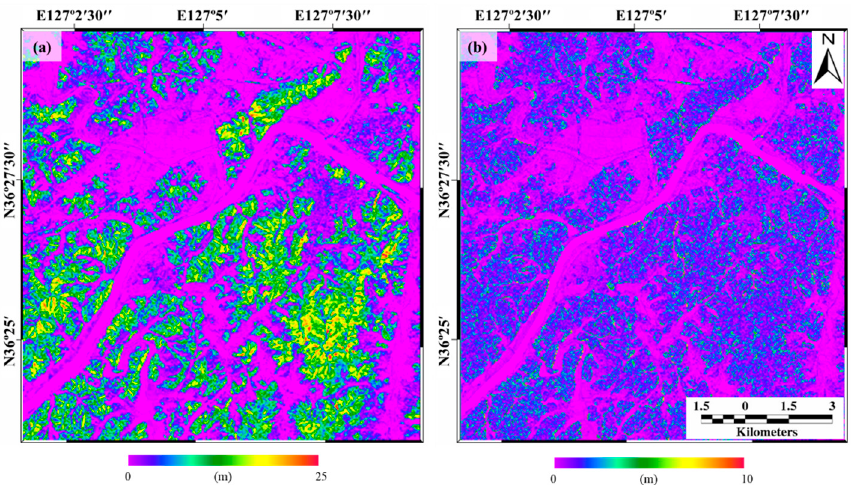
Figure 10. Canopy height maps estimated from DSM and DTM: ( a ) average canopy height map and ( b ) standard deviation canopy height map.